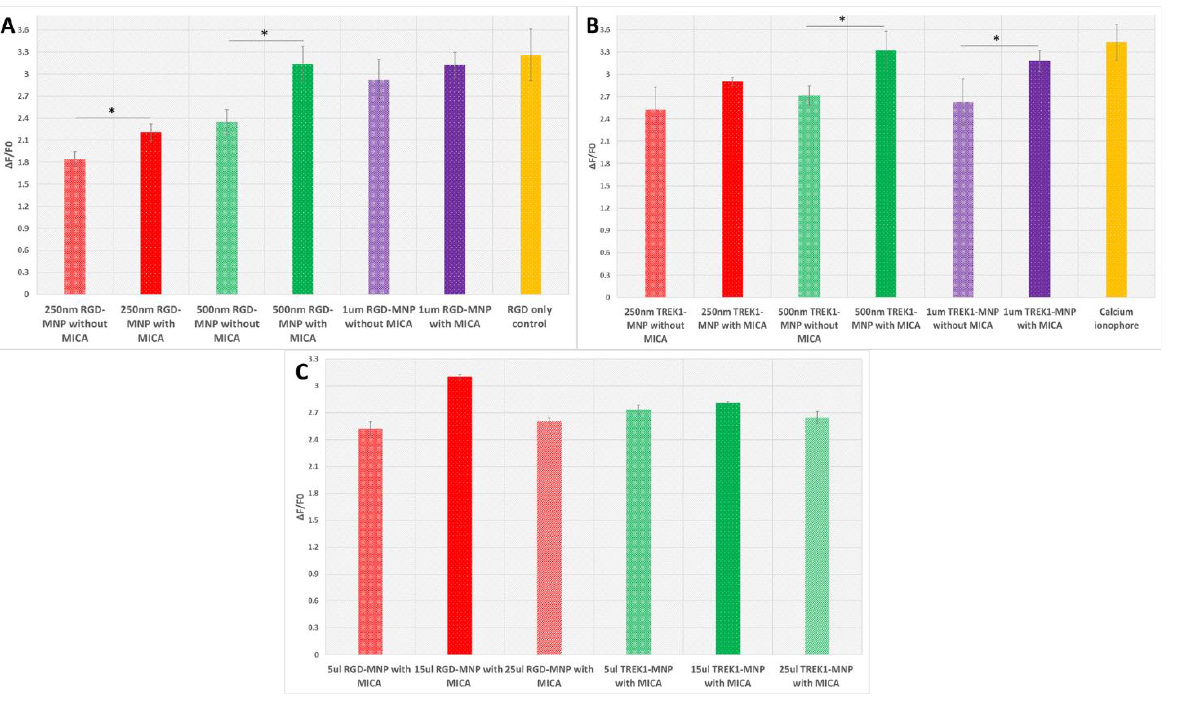
Figure 3. Size-dependent Fluo-8AM response with HEK293 cells labelled with ( A ) RGD-MNPs, ( B ) TREK1-MNPs, and ( C ) concentration-dependent Fluo-8AM response with RGD-MNPs and TREK1-MNPs after MICA application for 30 s (asterisks indicate significance in results using ANOVA test (* p < 0.05)).